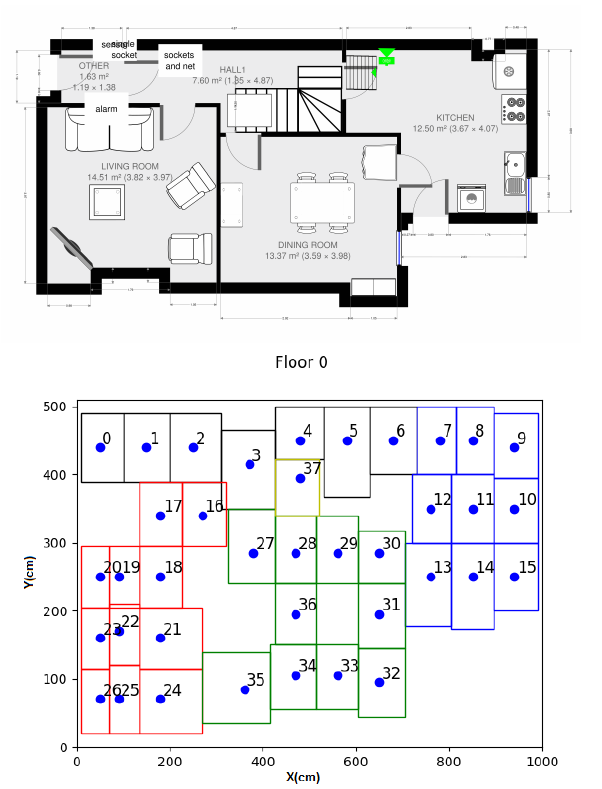
Figure 3. Example of discretised floor plan, for the use with fingerprinting. Figure above shows the corresponding floor